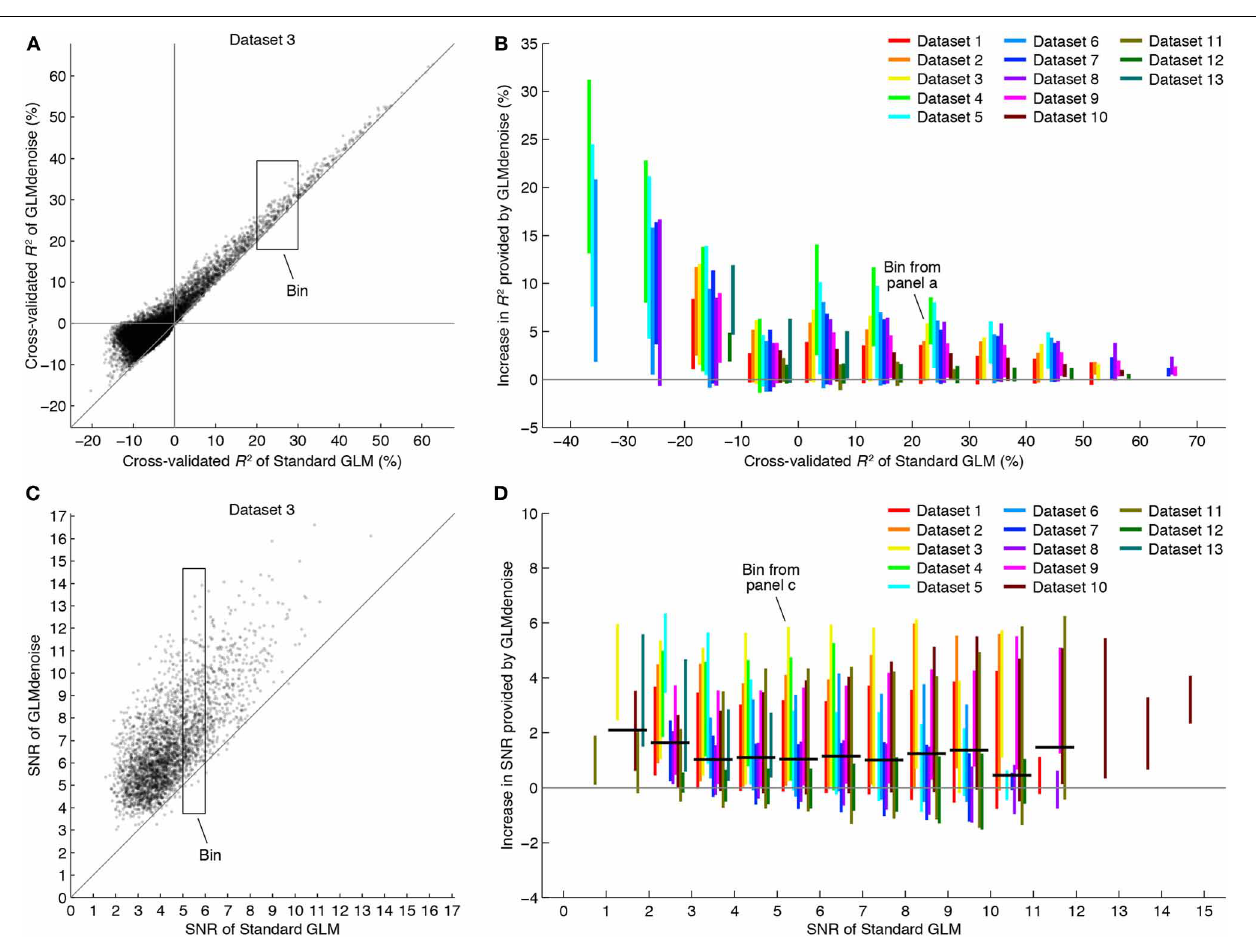
FIGURE 4 | GLMdenoise improves accuracy and reliability of BOLD response estimates. Using the DNB, we compared the accuracy and reliability of GLMdenoise to that of an analysis involving no noise regressors (termed Standard GLM). (A) Comparison of R 2 for an example dataset. Each dot indicates cross-validated R 2 values for an individual voxel. (B) Summary of changes in R 2 . Voxels are binned according to the cross-validated R 2 of Standard GLM (bin size 10%). For each bin with at least five voxels, we compute the increase in R 2 provided by GLMdenoise and plot a line indicating the 95% range of results. GLMdenoise provides more accurate